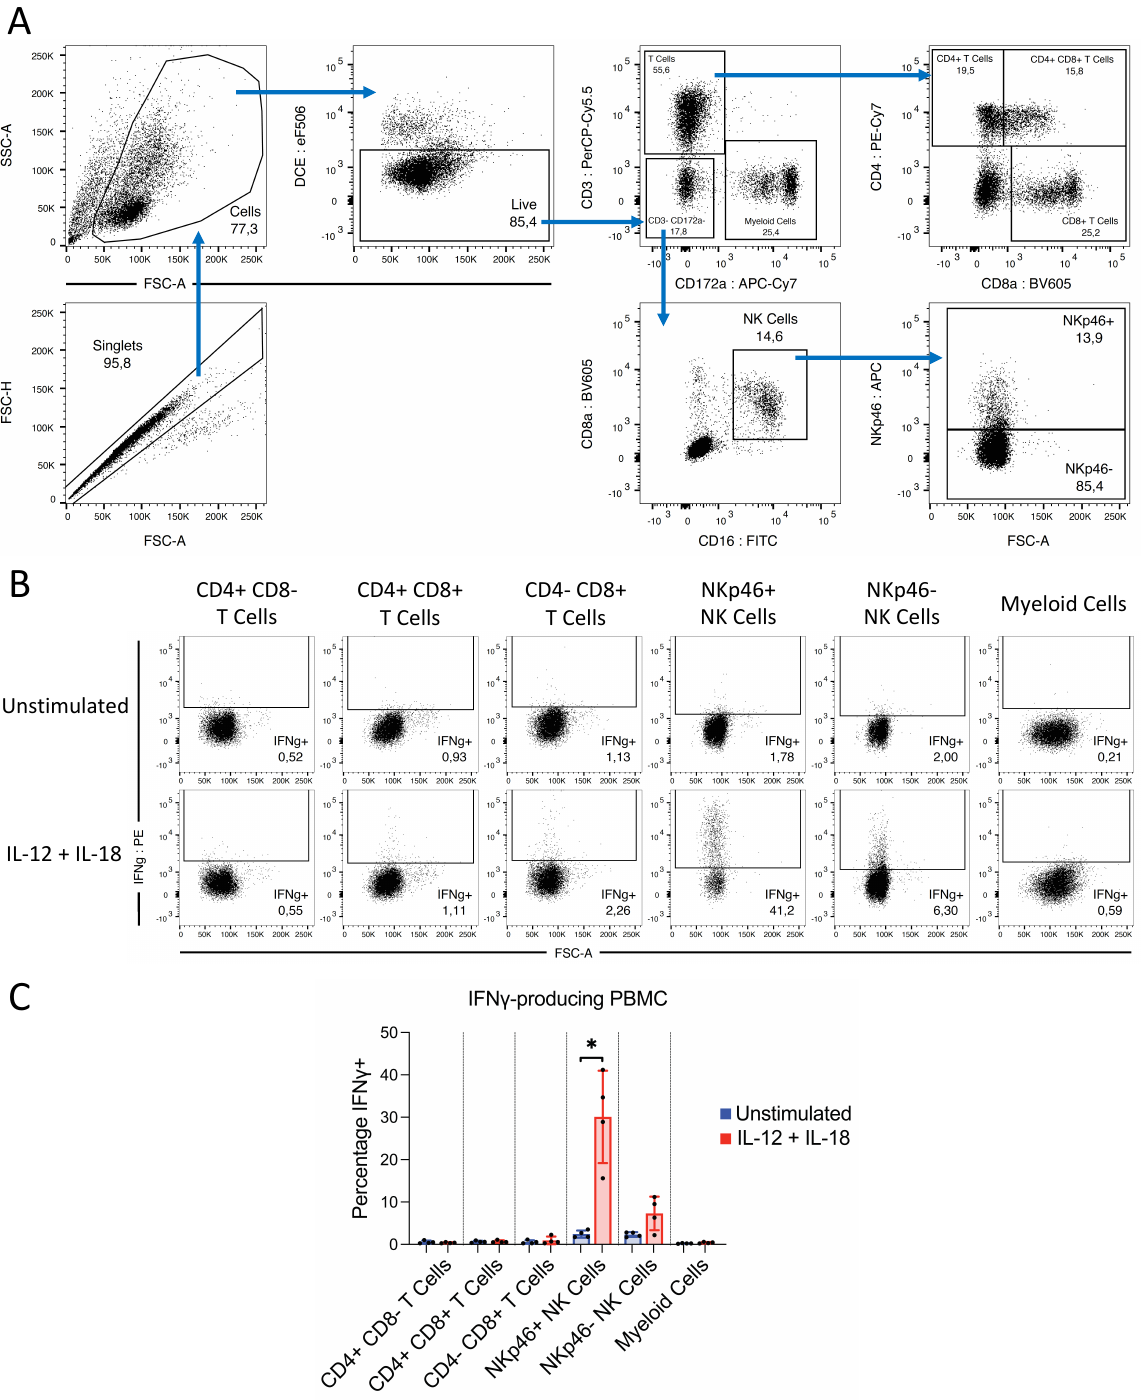
Figure 6. ( A ) Gating strategy used for PBMC subsets prior to analysis for IFN γ production. Cell aggregates and debris were excluded, followed by gating on DCE − live cells. The CD3+ CD172a − population consisted of T cells, which were further CD8 − , CD4+ CD8+, and CD4 − CD8+ subpopulations. The CD3– CD172a − population contained NK cells, which were identified by coexpression of CD8a and CD16, and further divided into NKp46+ and NKp46 − subpopulations. The CD3– CD172a+ population consisted of myeloid cells. ( B ) Representative staining illustrating upregulation of IFN γ expression by NKp46+ and NKp46 − NK cells following 12 h stimulation with recombinant IL-12p70 and IL-18. ( A , B ) FACS plots displaying forward and side-scatter values on a linear scale, while all fluorescent markers are displayed on a biexponential scale. ( C ) Percentage IFN γ + cells within T-cell and NK-cell subsets and myeloid cells. The analysis was performed with n = 4 pigs. Asterisks indicate statistical significance; paired t test; * p ≤